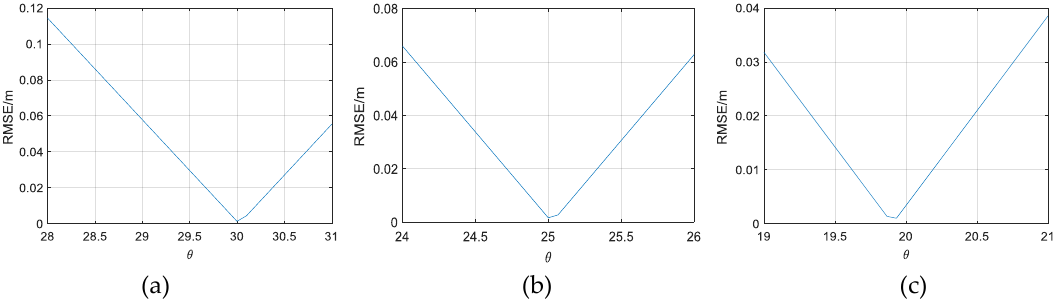
Figure 11. The estimations of the elevation angle of the three perspectives. (a)~(c) Variation of the RMSE of 3D reconstruction with respect to the elevation angle of the radar LOS in different perspectives.